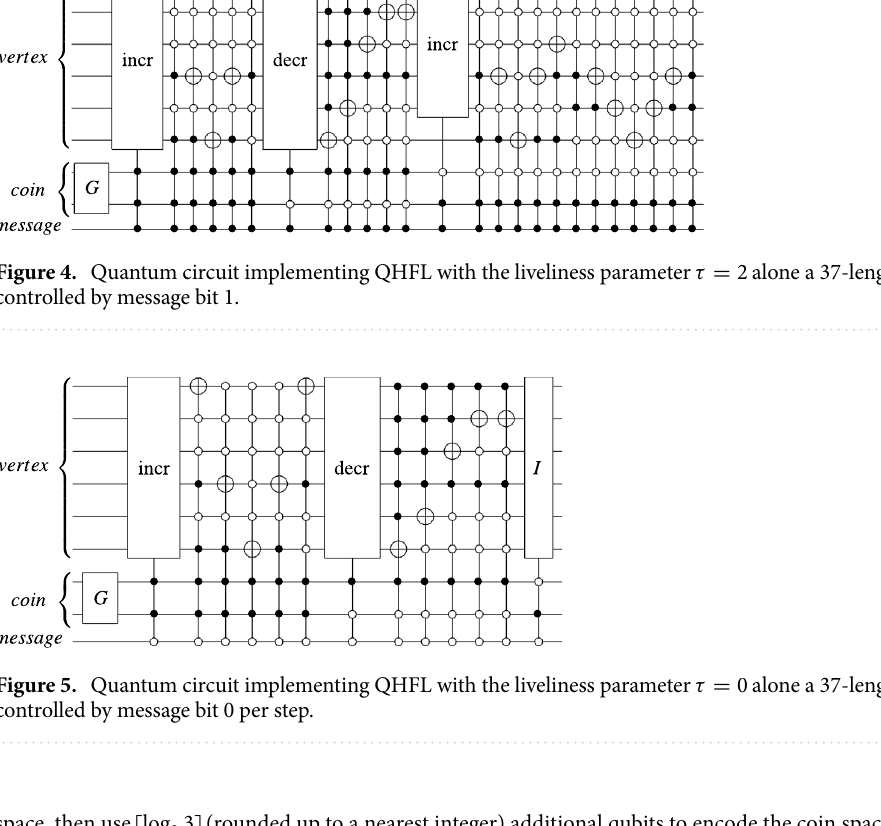
Figure 5. Quantum circuit implementing QHFL with the liveliness parameter τ controlled by message bit 0 per